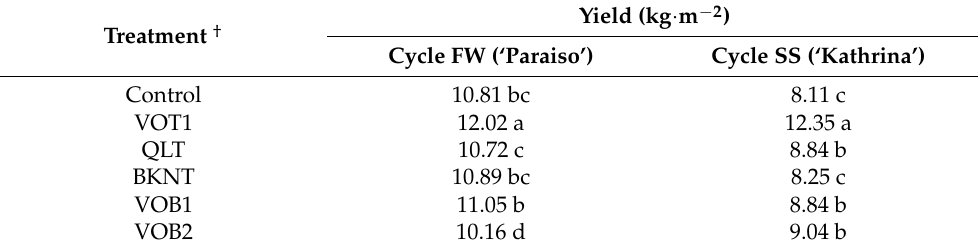
Table 6. Fruit yield of cucumber plants during FW and SS cycles.